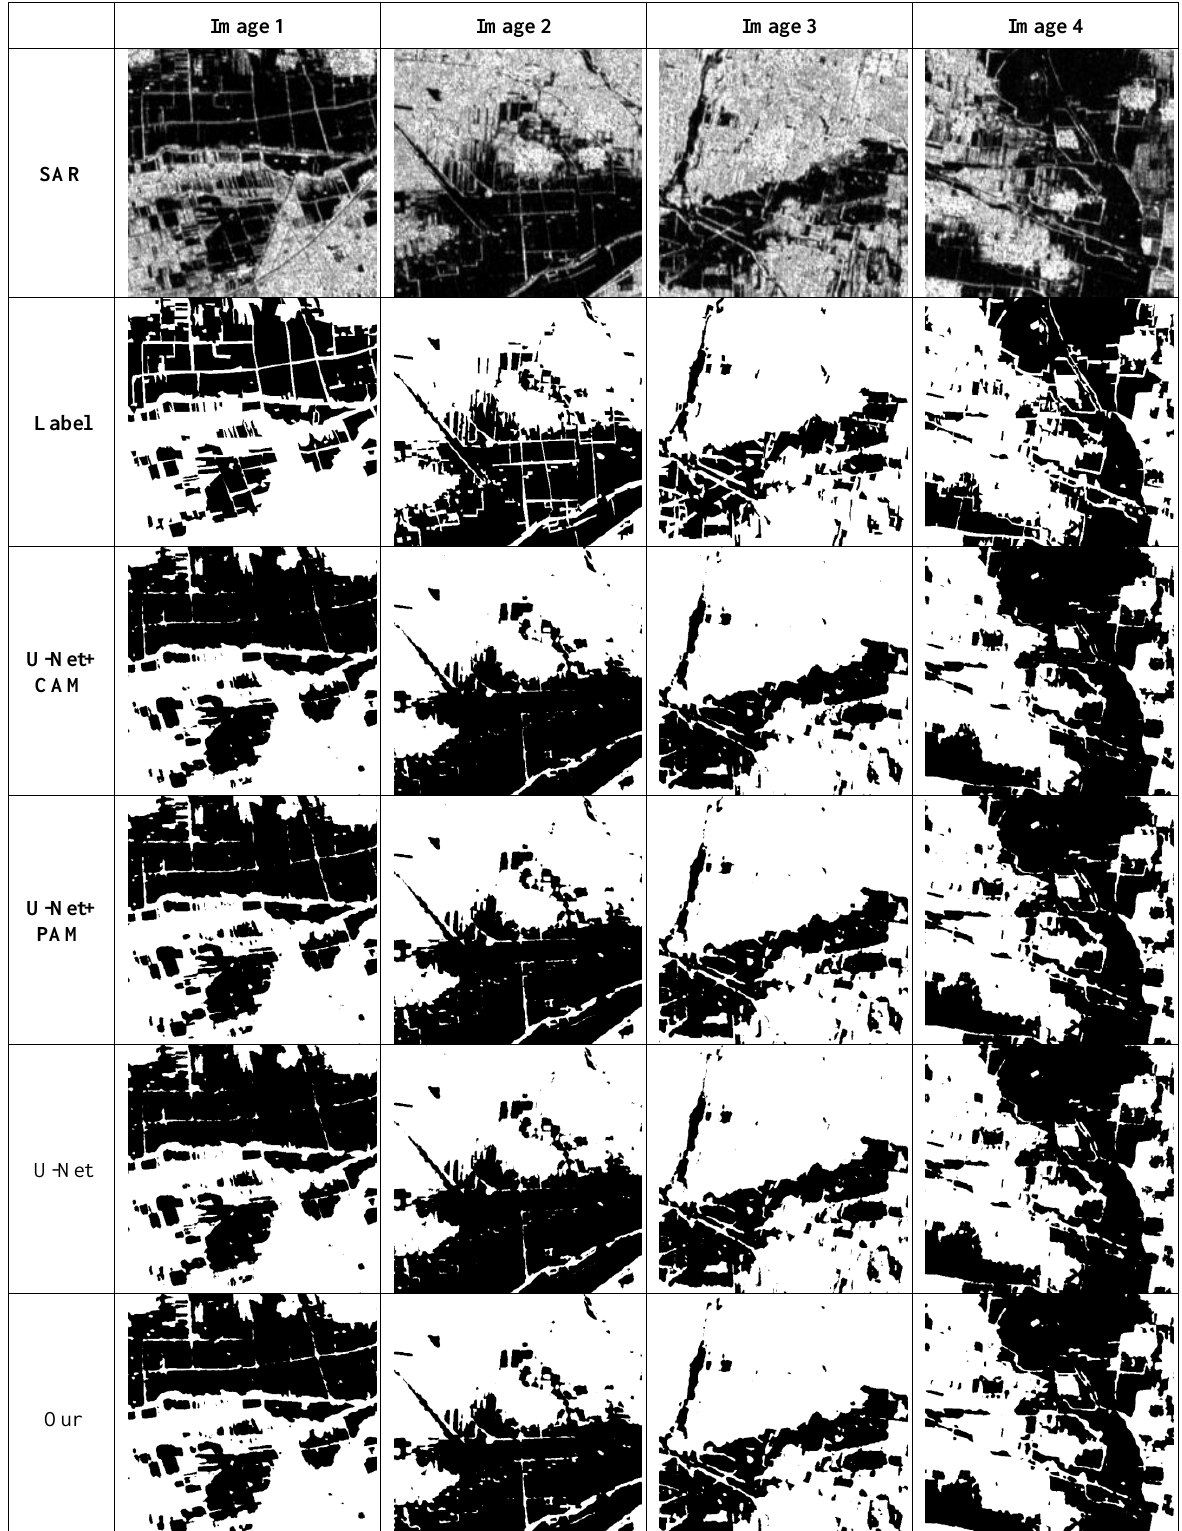
Figure 4. Experimental setup used in the